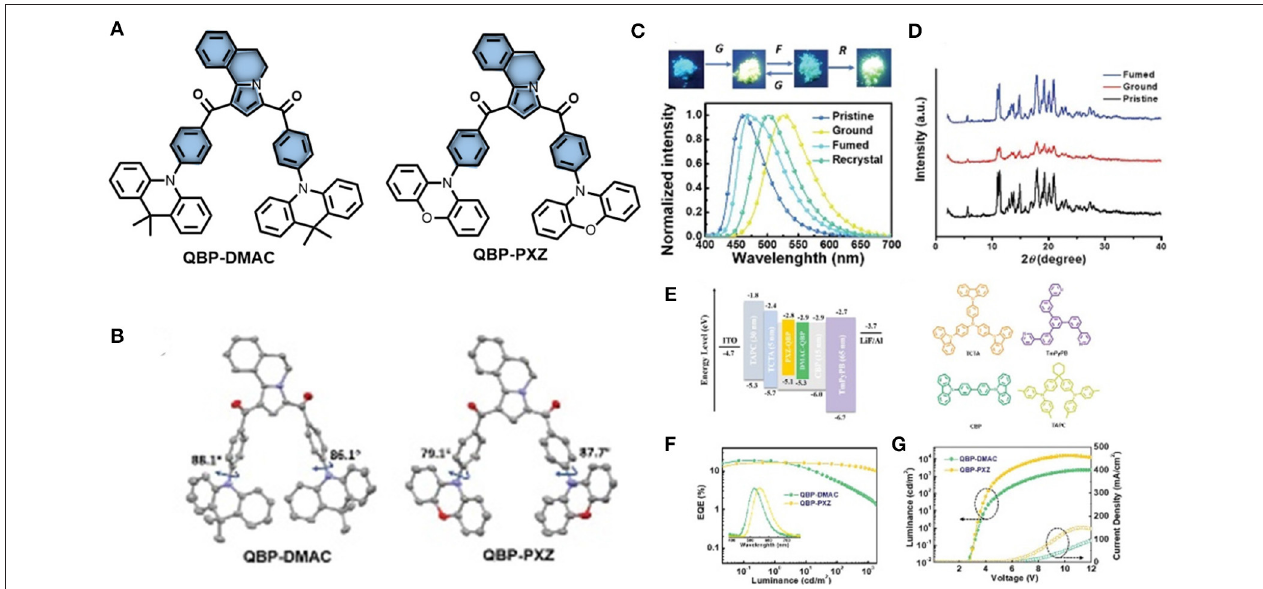
FIGURE 11 | (A) Chemical structure of QBP-PXZ and QBP-DMAC (B) molecular configurations in single crystal XRD (hydrogen excluded). (C) PL spectra and MCL images of QBP-DMAC in (under 365nm UV light) (D) PXRD patterns of QBP-DMAC. (E) Energy level diagram, device and material structures (F) luminance vs. EQE plots. Inset: Normalized EL spectra. (G) Luminance–voltage–current density plots. Reproduced with permission from Zheng et al. (2019b). Copyright © WILEY-VCH Verlag GmbH andamp; Co. KGaA, Weinheim.